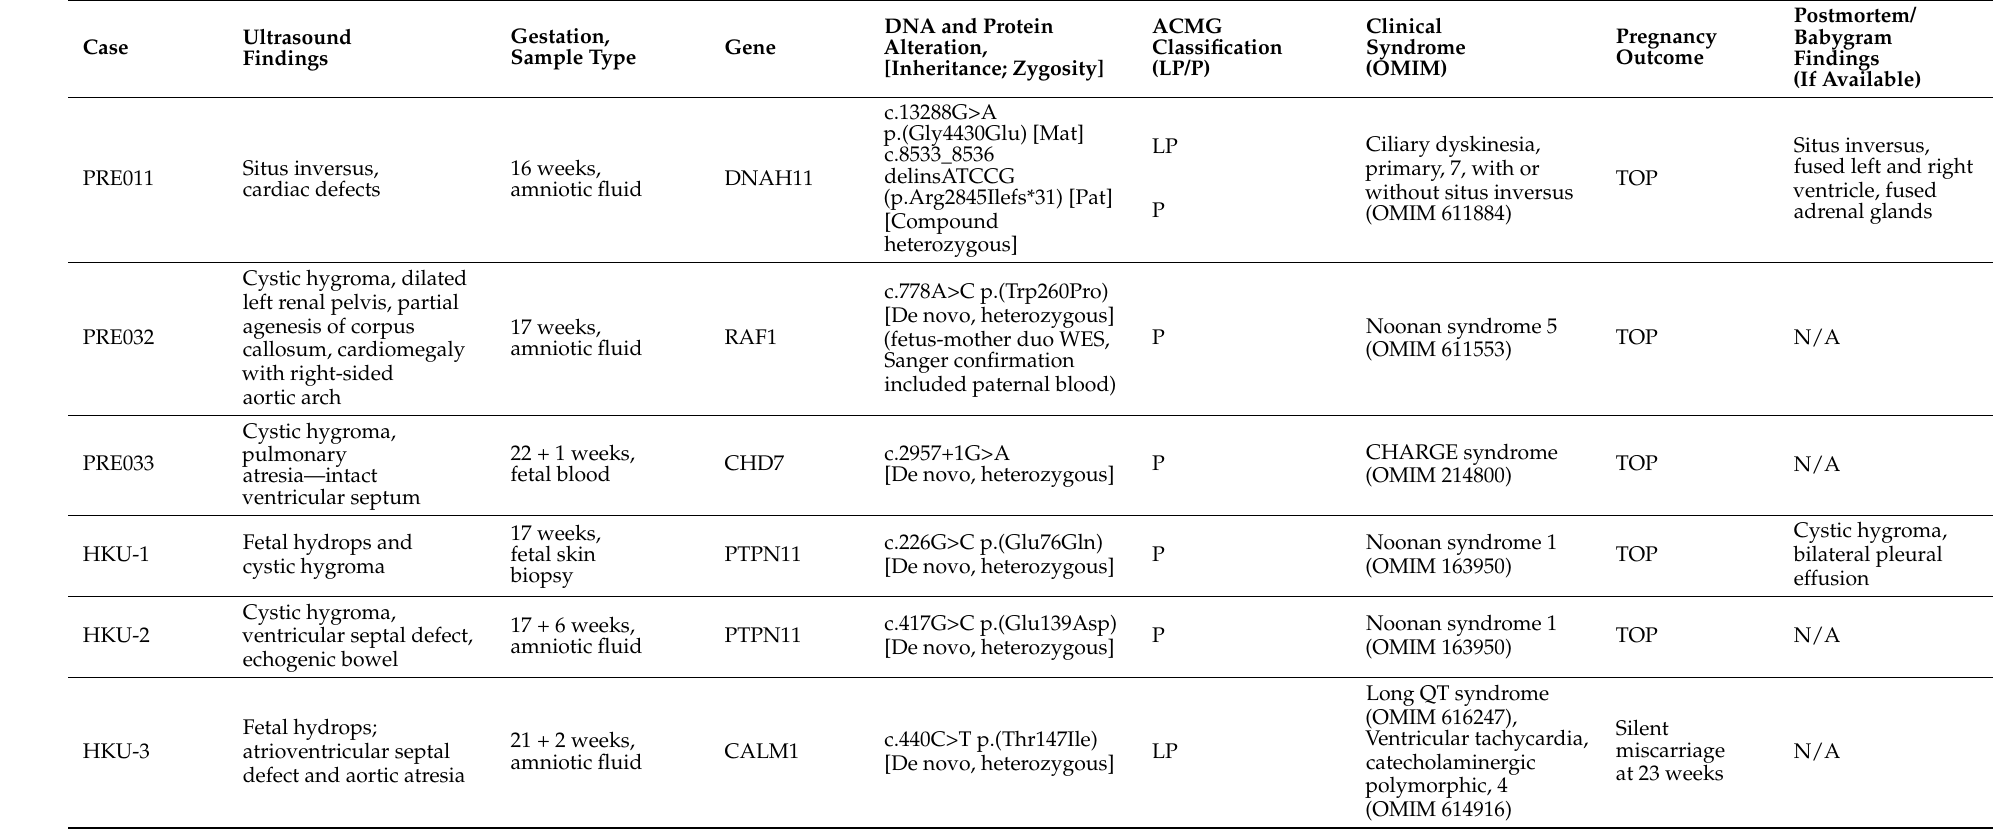
Table 1. List of likely pathogenic and pathogenic disease variants identified by prenatal